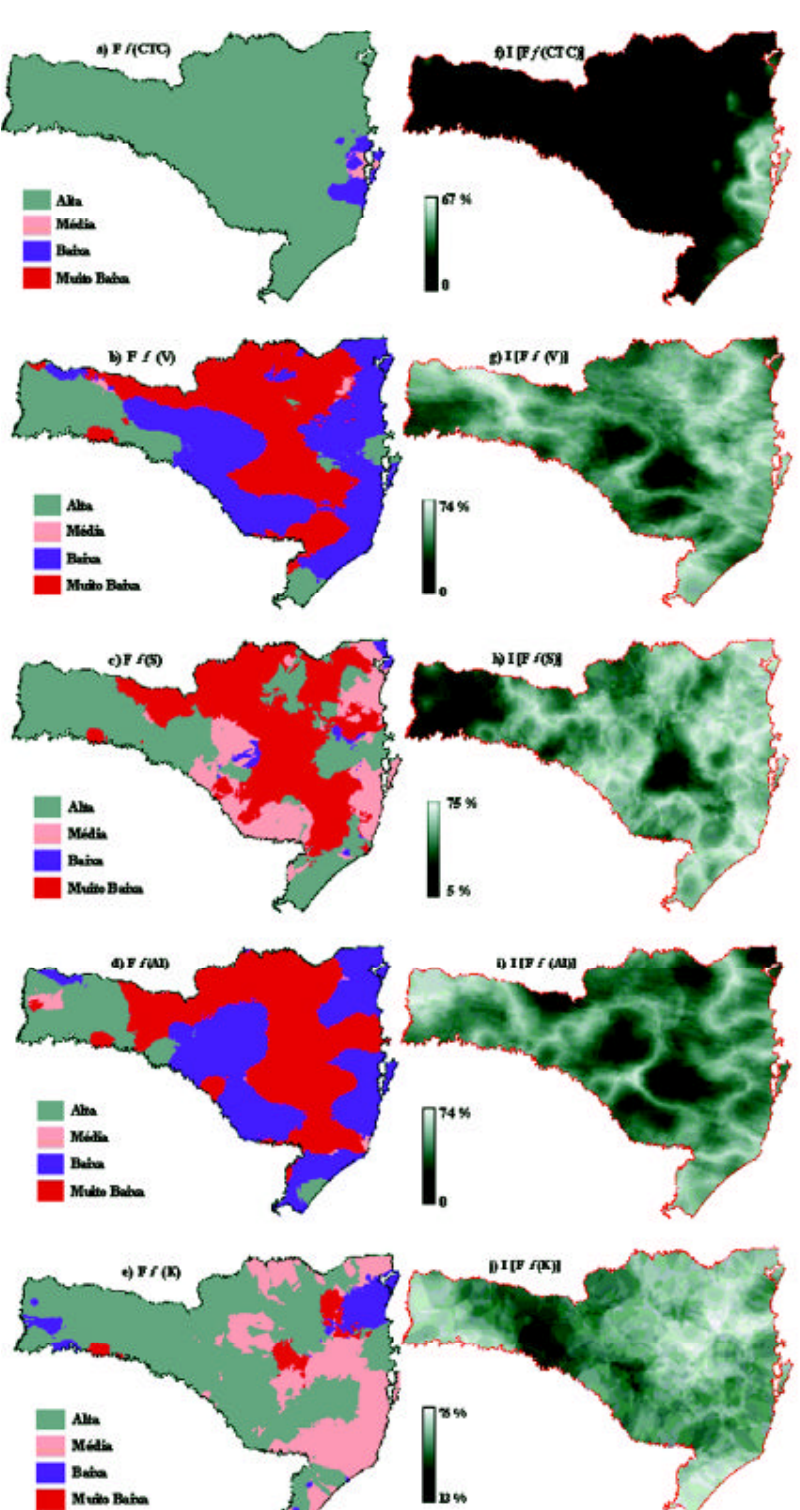
Figura 2. Espacialização das variáveis de solos: capacidade de troca catiônica, saturação por bases, soma de bases e teores de alumínio trocável e de potássio trocável, expressas por atributos categóricos de fertilidade [Fƒ(CTC), Fƒ(V), Fƒ(S) Fƒ(Al) e Fƒ(K)], e incertezas associadas [I [Fƒ(CTC)], I [Fƒ(V)], I [Fƒ(S)], I [Fƒ(Al)] e I [Fƒ(K)]], com a legenda do mapa de incertezas, em escala de cinza, indicando a probabilidade (em percentagem) de que a classe do atributo considerado exceda a classe definida como mais